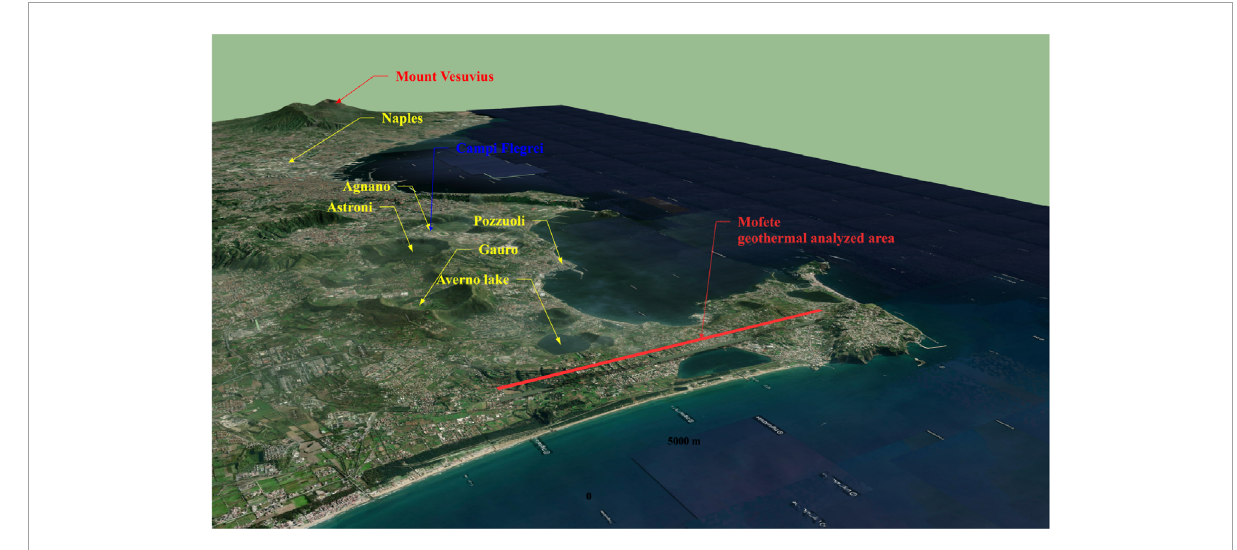
FIGURE 1 3D view of the geothermally analyzed area in Naples,